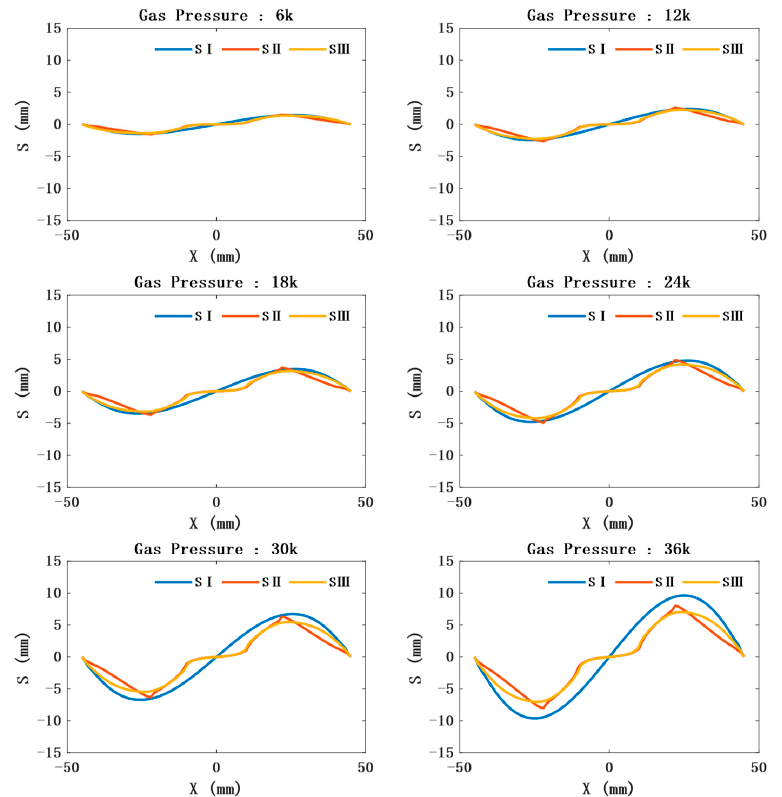
Figure 6. Relationship between the distance from the central axis of the model (the horizontal position relative to the ambient air pressure of 0 Pa) and the horizontal displacement under different air pressures. SI represents the relationship between the distance of the CTPM from the central axis and displacement under different air pressures. SII represents the relationship between SAM’s maximum constraint, that is, the distance between each point on the line constrained by three sensors and passing through the central axis, and the horizontal displacement. SIII represents the relationship between SAM’s minimum constraint, that is, the distance between each point on the line constrained by only one sensor in the center and passing through the central axis, and the horizontal displacement.